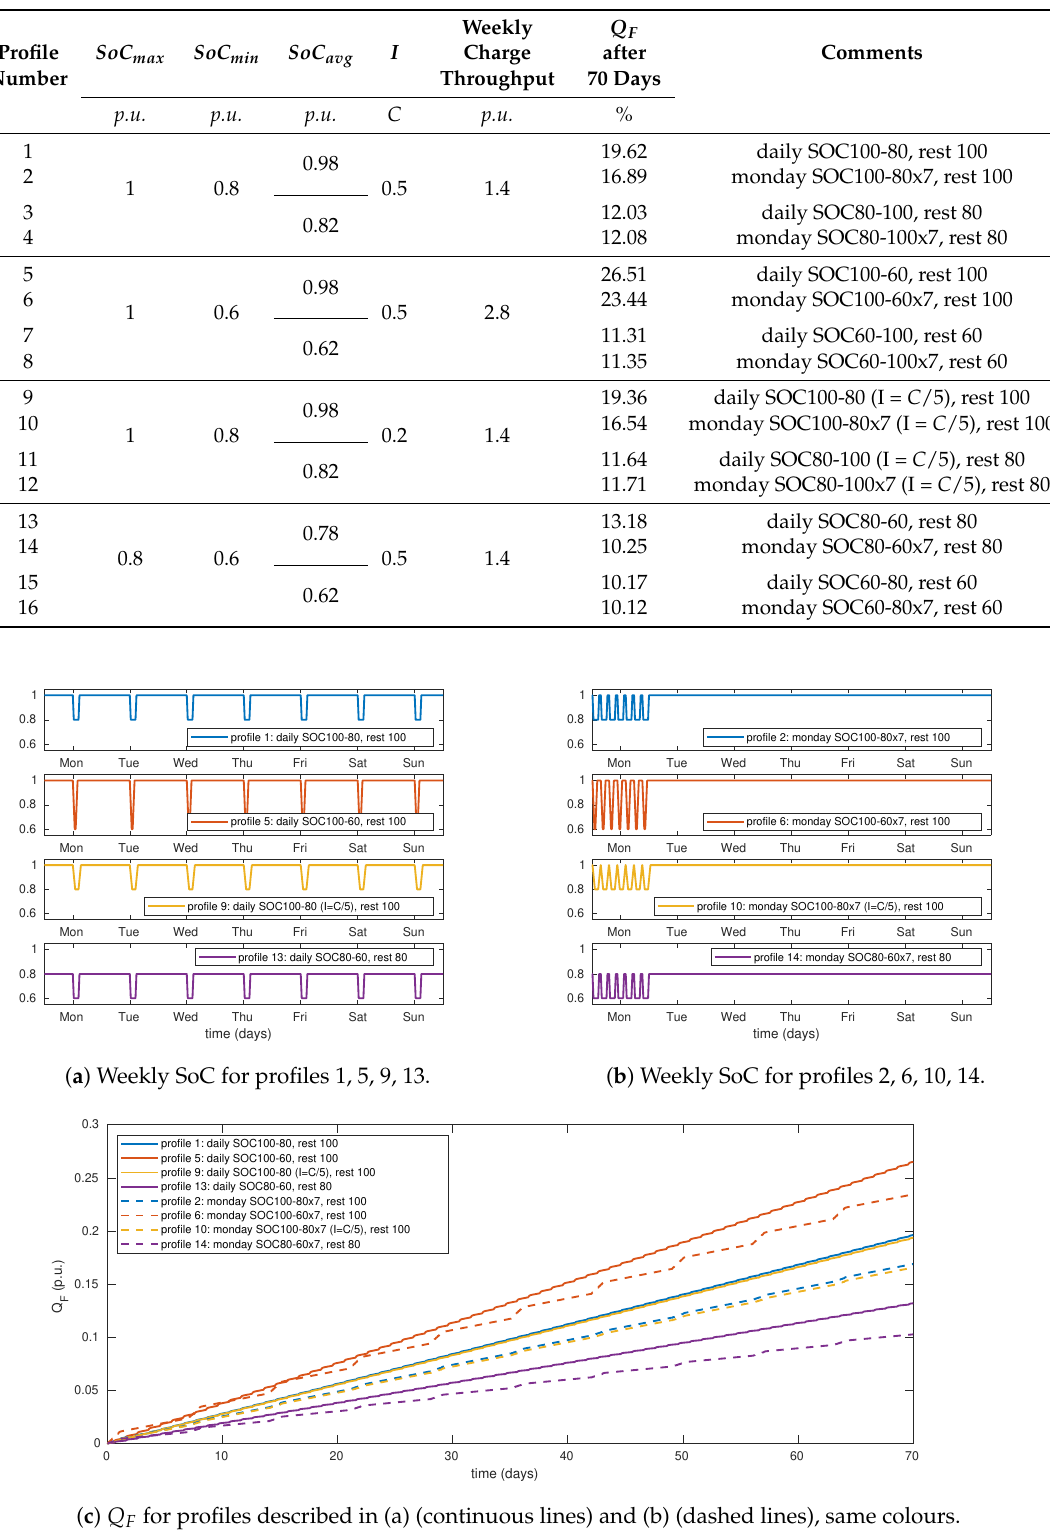
Table 4. Simulation results for different use profiles. Underlined values are showing the differences between each four profile group (profiles 5 to 8, 9 to 12 and 13 to 16) respect to the original profiles (1 to 4).